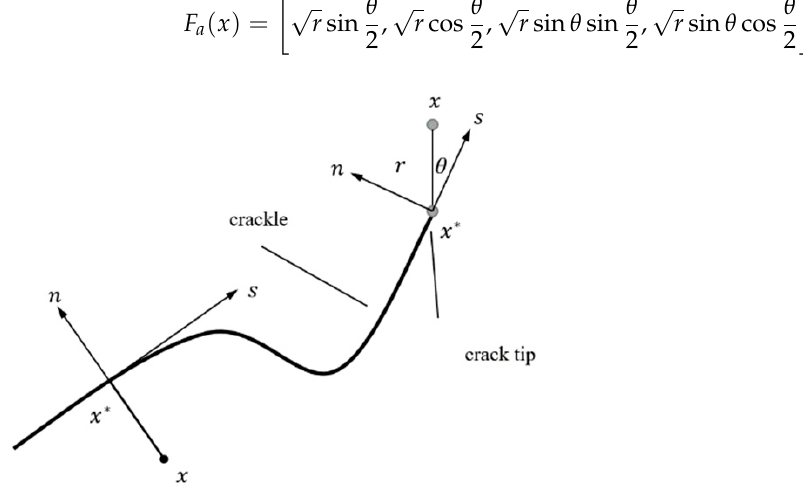
Figure 1. Pole axis of crack tip, where x is the sample point; x * is the nearest point in the crack spacing to x ; n is the unit out normal vector of x* in the crack.